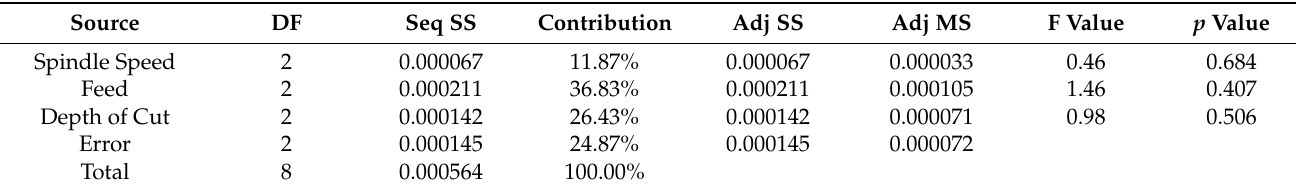
Table 14. Analysis of variance for transformed response for